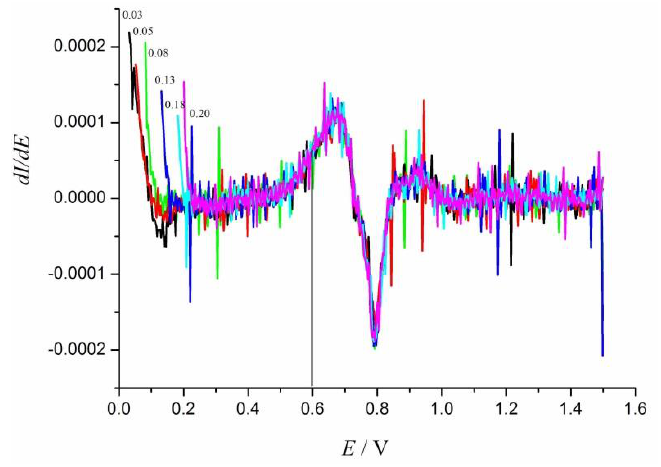
Figure 4. Anode branches of CVA curves in d I /d E scale after the delay of potentials ( E in Volts). Black line: 0.03; red line: 0.05; green line: 0.08; blue line: 0.13; cyan line: 0.18; magenta line: 0.20. Scan rate 0.01 Vs −1 .